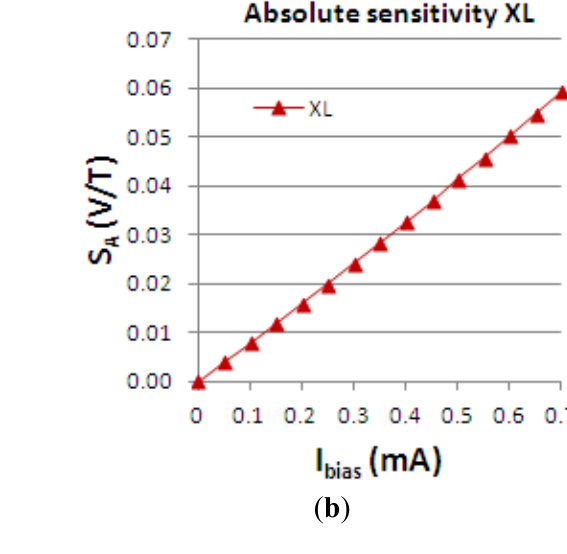
Figure 1. Measured 4-phases residual offset voltage vs. biasing current ( a ) and absolute sensitivity vs. biasing current ( b ) for XL